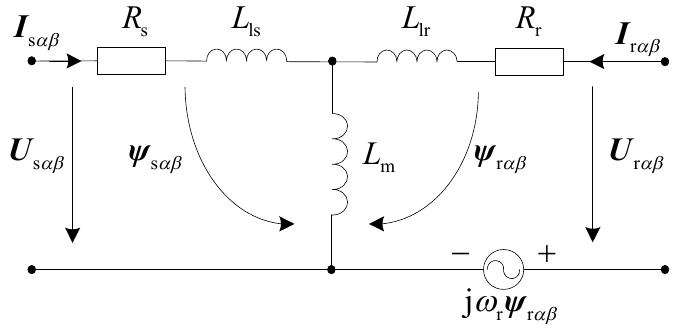
Figure 1. Doubly fed induction generator (DFIG) equivalent circuit in the stationary reference frame.